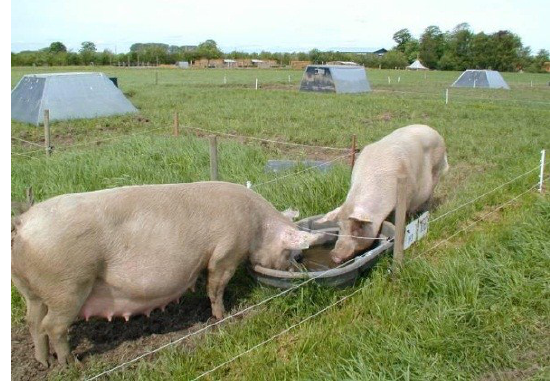
Figure 1. Lactating free-range sows.